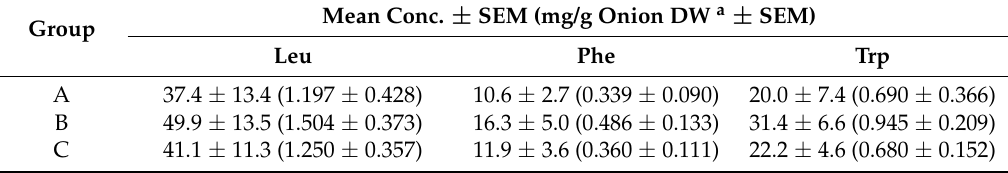
Table 4. The means ± SEM of concentration values determined for the selected amino acids of interest in the three groups studied (A–C). SEM is for “standard error of the